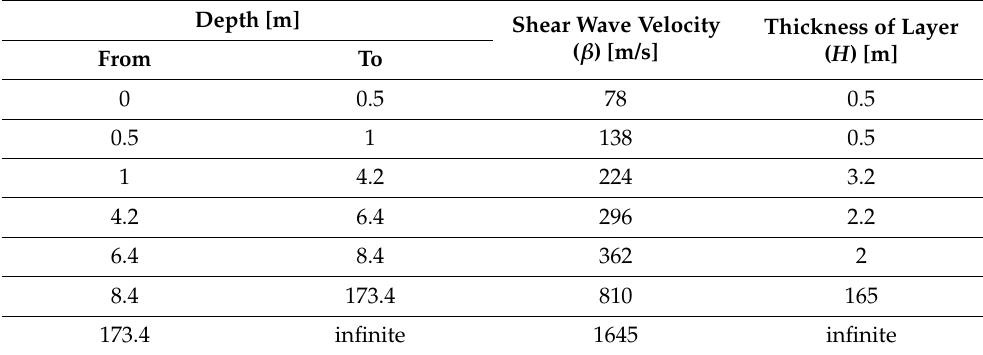
Table 3. HVSR results at Selva Bocchetto, near the case study viaduct, in terms of shear wave velocities and depths.